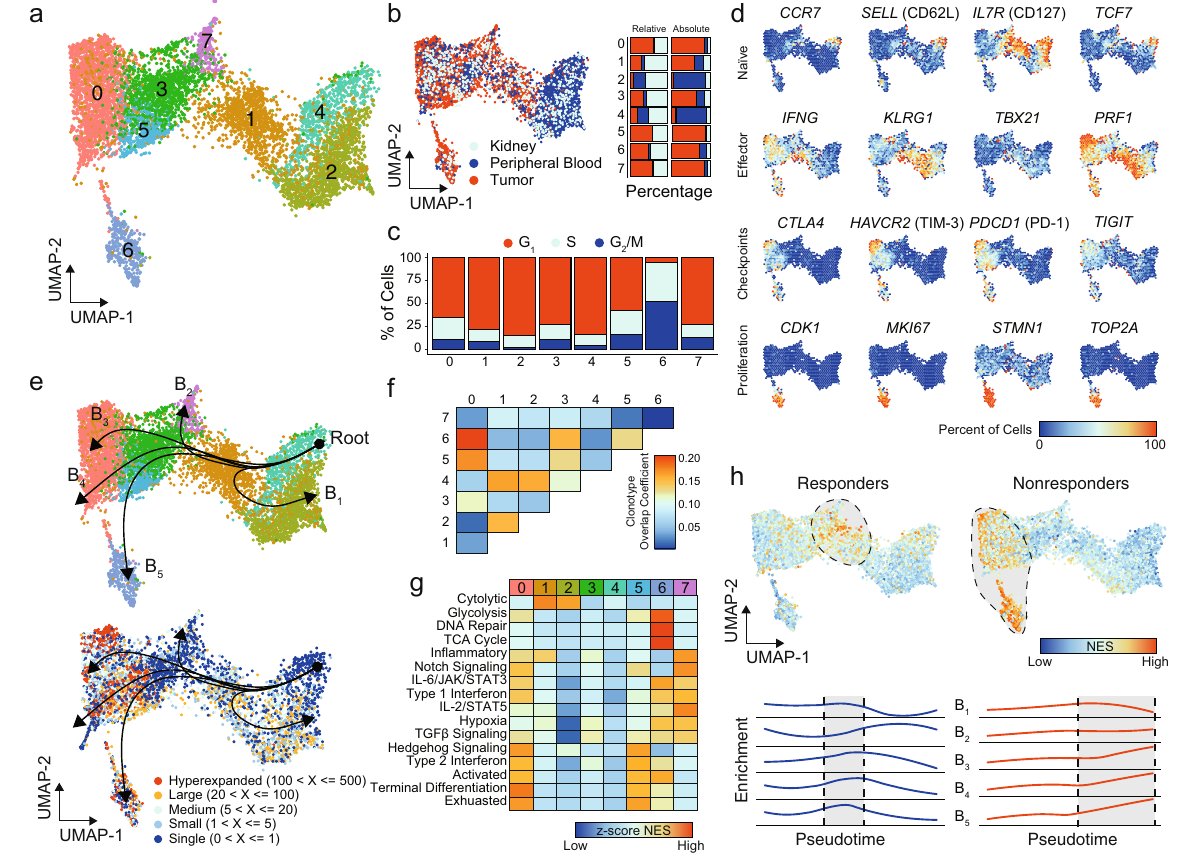
Fig. 3 CD8 + T cells in ccRCC tumors exhibit a transcriptional continuum with distinct populations. a UMAP subclustering of CD8 + T cells (original clusters 1, 8, 9, and 17). b UMAP distribution of single cells by tissue type with relative and absolute percent of cells by tissue in each cluster. c Cell-cycle regression assignments for CD8 + T cells by cluster assignment. d Percent of cells expressing selected markers for T-cell biology. e CD8 + UMAP of clusters (upper panel) and clonotype frequency (lower panel) overlaid with slingshot-based 36 cell trajectory starting at CD8_4 and proceeding into fi ve distinct curves: branch 1 (B 1 ), B 2 , B 3 , B 4 , and B 5 . f Clonotype overlap coef fi cients between subclusters. g Z-transformed normalized enrichment scores from ssGSEA for selected gene sets by subcluster. h Normalized enrichment scores for therapeutic response or lack of response to anti-PD-1 therapy across the CD8 + T cells (upper panel) and by pseudotime of each branch (lower